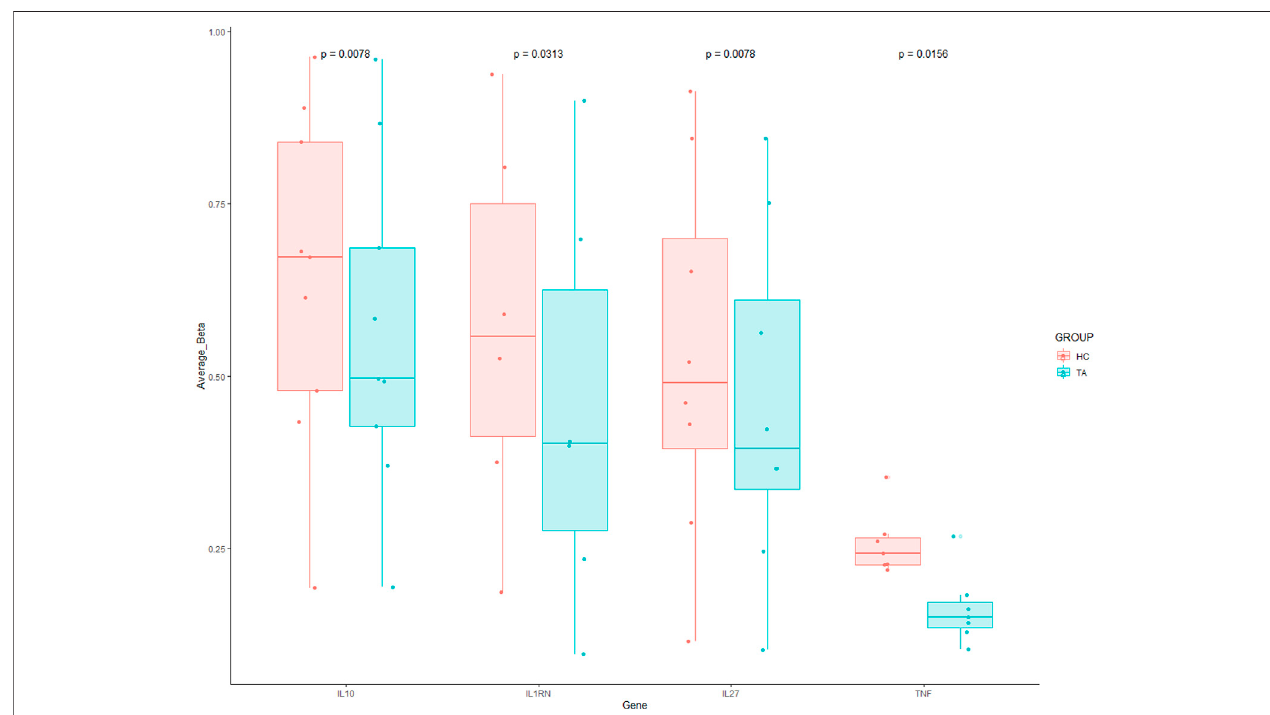
FIGURE 3 | Signi fi cantly hypomethylated genes in γδ T cells of patients with TA. Each dot indicates each CpG probe measured within this gene. A Wilcoxon matched paired test was used to compare between the groups against each CpG probe.